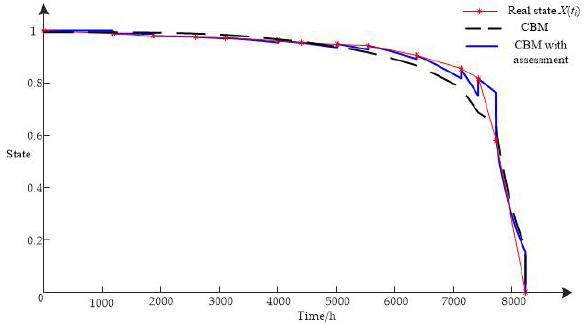
Fig. 4. Gearbox 1 state diagram under CBM